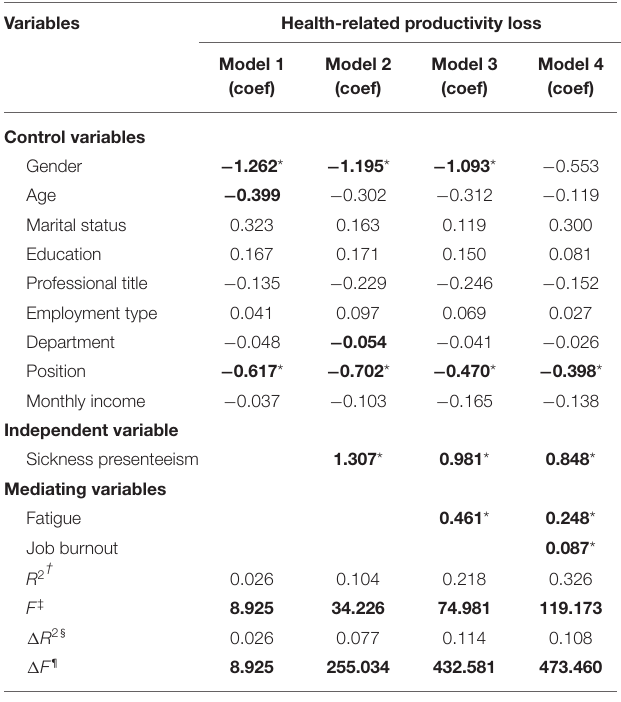
TABLE 4 | Hierarchical linear regression analysis of variables related to health-related productivity loss ( N = 2,968).